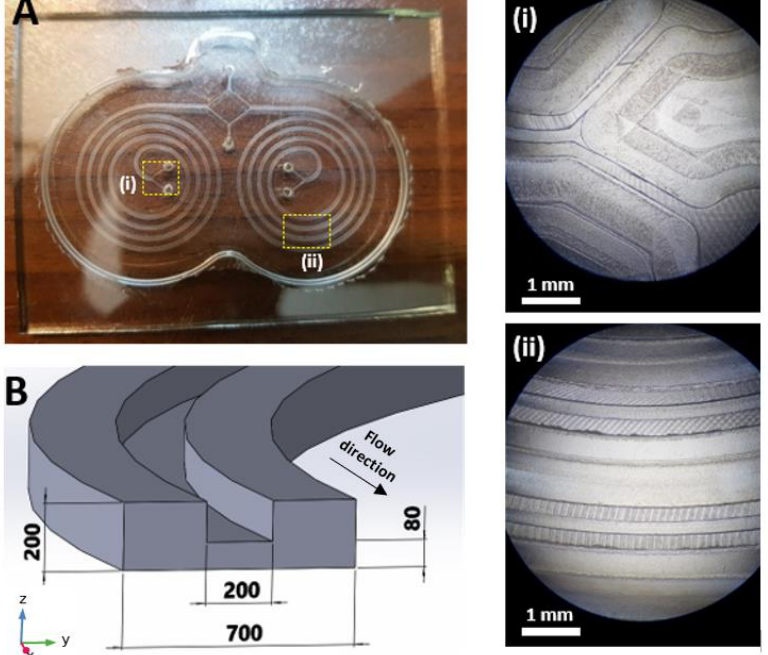
Figure 1. ( A ) The 4-loop parallel spiral microchannels fabricated in PDMS with the corresponding mold preview. ( i ) The magnified view of section ( i ). ( ii ) The magnified view of section ( ii ). ( B ) Schematic of the cross-section of the spiral microchannel (The dimensions are in µm).